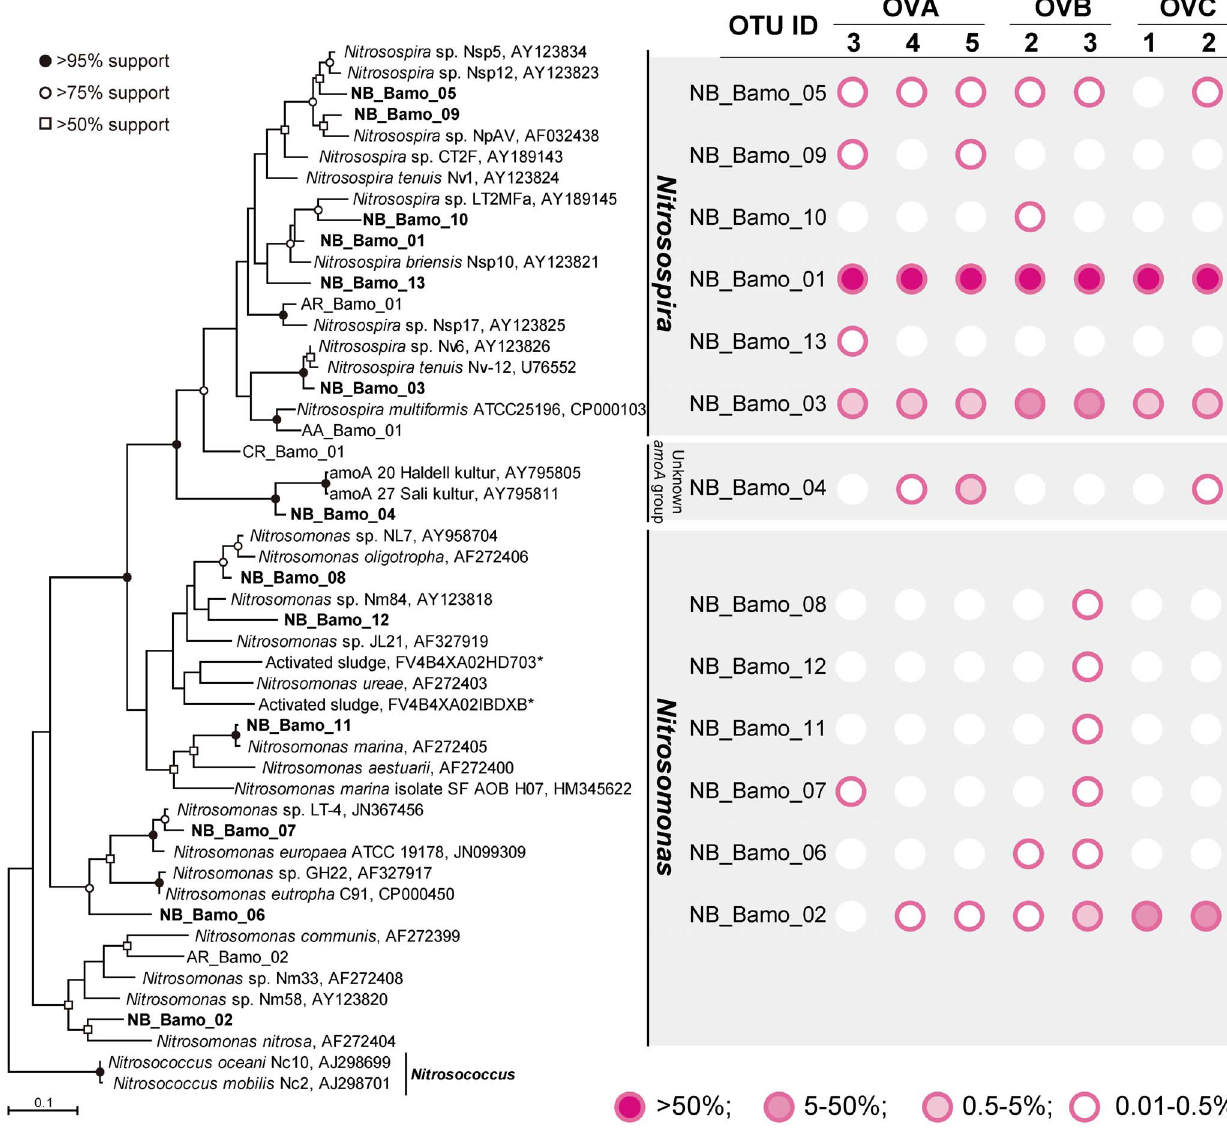
Figure 2. Distance matrix tree of bacterial amoA gene sequences retrieved from niter-bed soils based on the maximum likelihood method. Boldface indicates the sequences obtained in this study. The Nitrosococcus amoA gene sequences (AJ298699 and AJ298701) were used as outgroups. The bar indicates 10% base substitution. Branching points supported probabilities . 95%, . 75%, and . 50% by bootstrap analyses (based on 1,000 replicates, estimated using the maximum likelihood method) are indicated by solid circle, open circles, and open square,